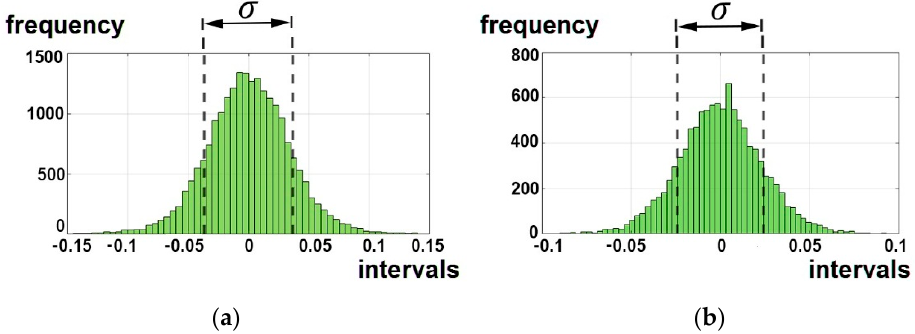
Figure 1. Histograms of tree nodes, Daubechies 3: ( a ) node (2, 1); ( b ) node (5, 1).